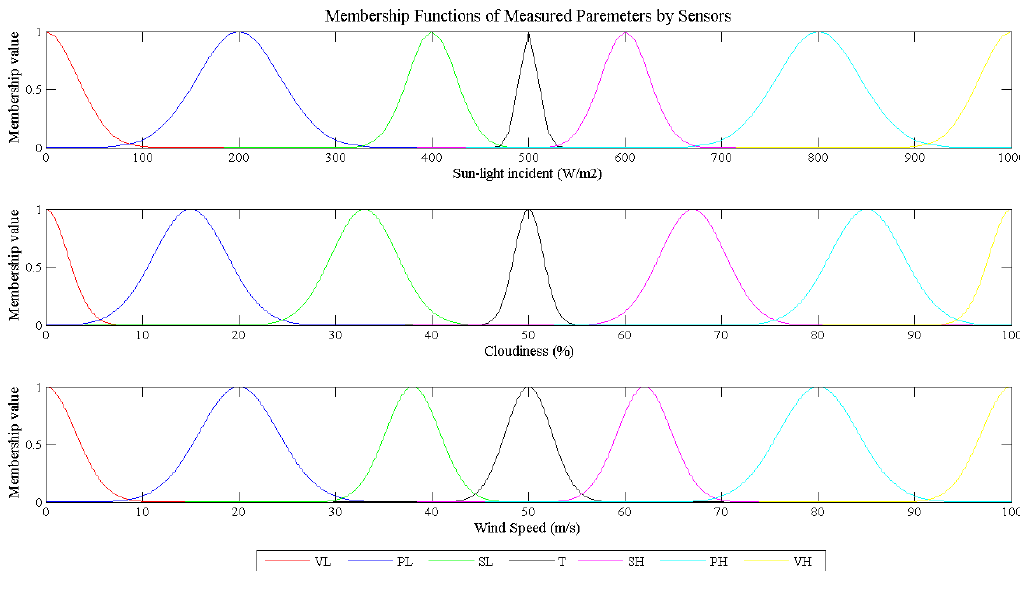
Figure 3. Membership functions of S ( t ), C ( t ) and W ( t ).